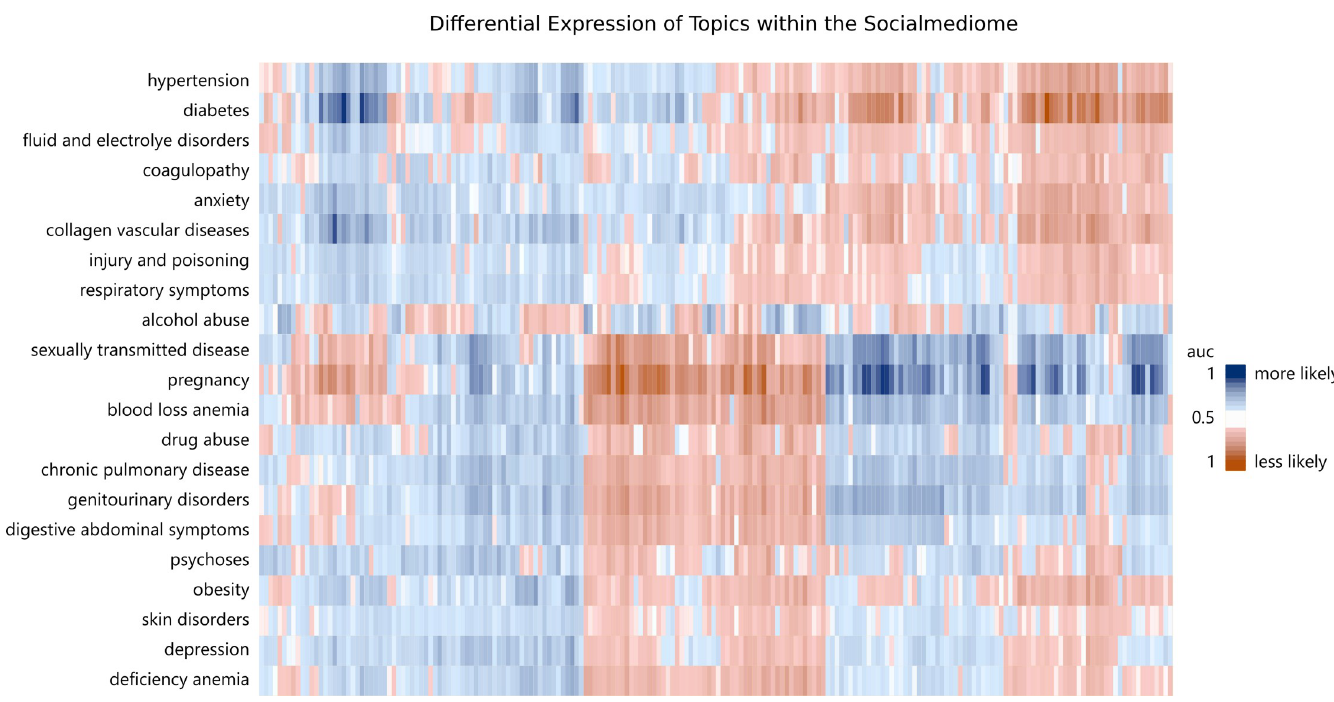
Fig 3. Differential expression of topics across medical conditions within the social mediome. Analogous to studying the differential expression of a genome, topics of the social mediome can be explored differentially across diagnoses. The 21 rows represent all medical condition categories of the study ordered using hierarchical clustering while the 200 columns indicate the predictive strength[24] (measure by area under the ROC curve ) of each potential language marker (topics). Blue topics were more likely to be used by patients with the given medical condition and orange topics were less likely to be mentioned. Medical condition categories each have unique patterns of markers. These encodings allow for the prediction of diagnoses and identification of diagnoses with similar patterns of markers.